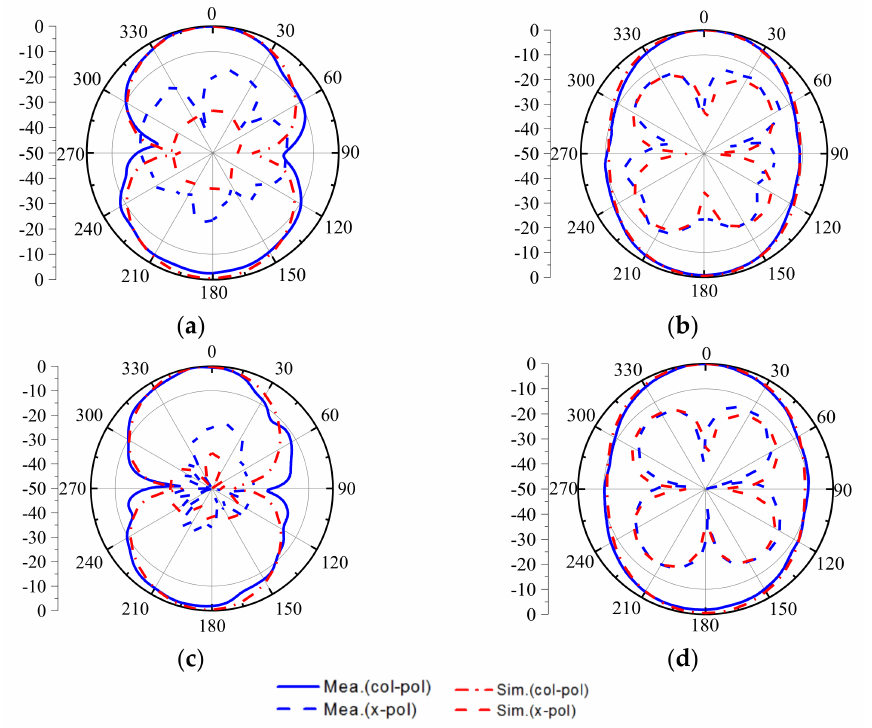
Figure 13. Simulated/measured radiation patterns of the proposed antenna, ( a ) xoz plane@2.5 GHz ( b ) yoz plane@2.5 GHz ( c ) xoz plane@3 GHz ( d ) yoz plane@3